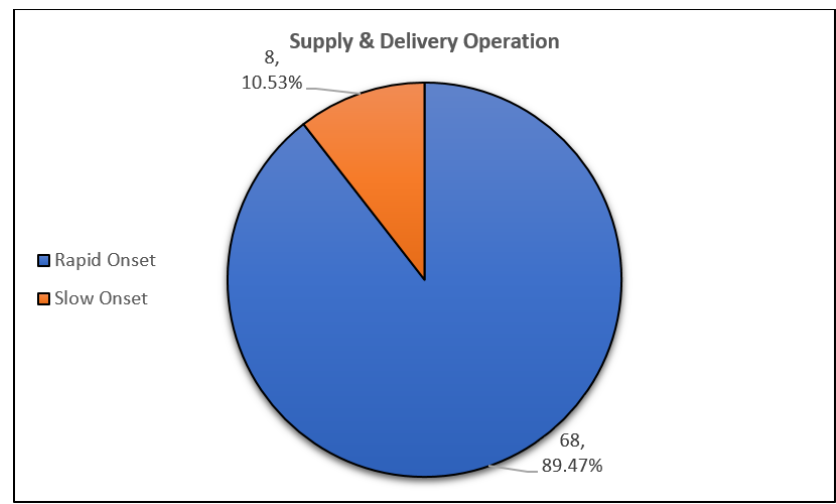
Figure 12. Breakdown of Vehicle Routing Problem (VRP) for Supply & Delivery Operation based on Disaster Type.